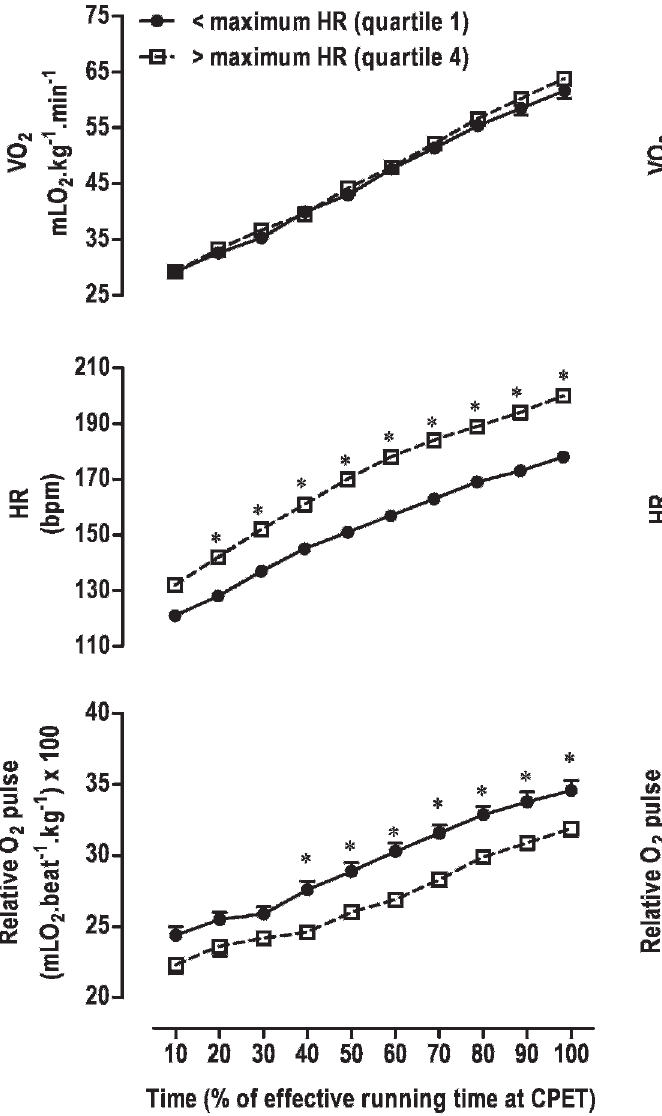
Figure 1 - Heart rate, oxygen consumption and oxygen pulse curves during maximal cardiopulmonary exercise testing for athletes at extreme quartiles of maximum heart rate (n = 45). Error bars represent the standard error of the mean.